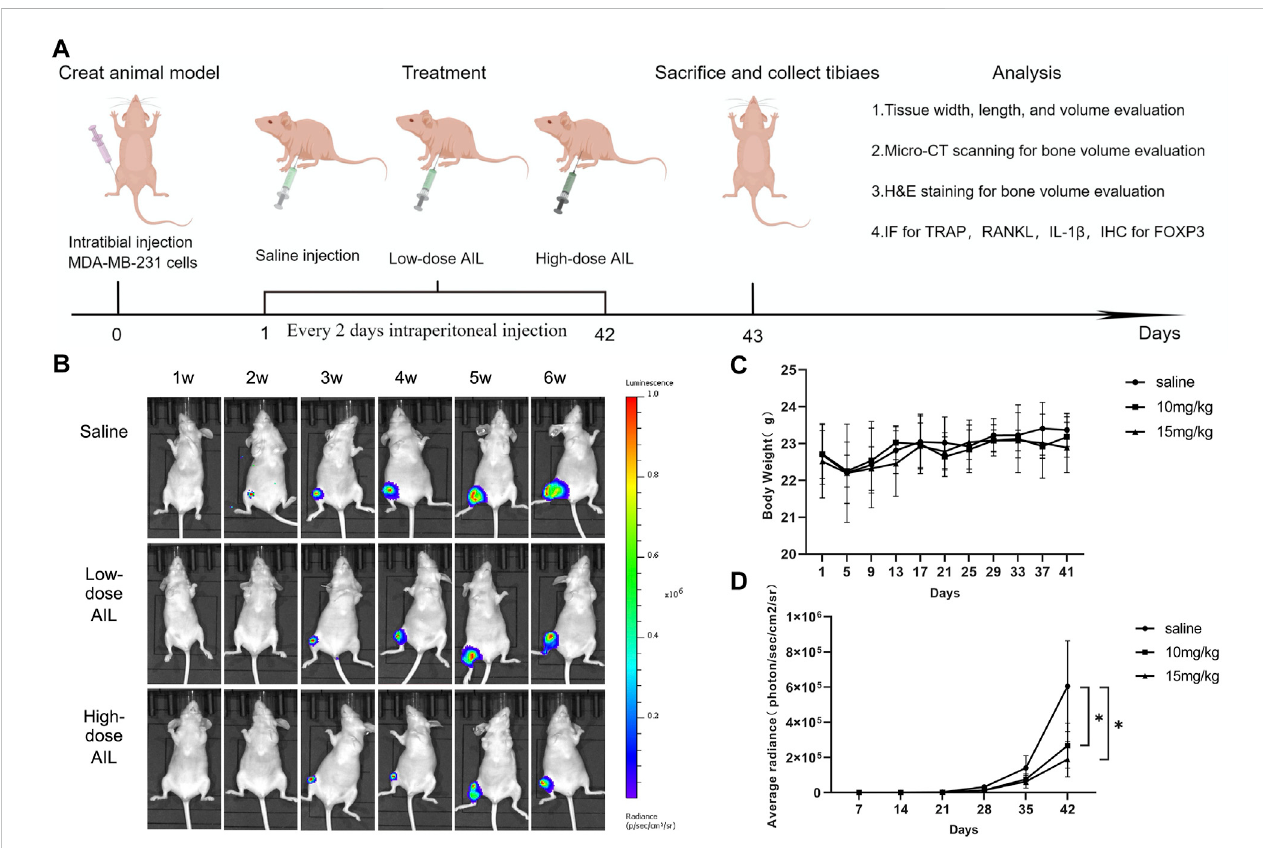
AIL prevents bone metastases and osteolysis brought on by BC and inhibits the evolution of the disease, in vivo . (A) The in vivo treatment timeline was created using the Figdraw software (ID: AIATW58585). A BC-induced bone metastasis model in mice was developed by injecting Luc cells into right tibial plateau of nude mice. (B) Non-invasive IVIS was used every week to identify the representative bioluminescence images for developing MDA-MB-231 Luc cells in the tibia of nude mice. (C) Every 4 days, the body weight variations in every group were assessed. (D) The graphs depicting the bioluminescence activity of tumor cells in the bone microenvironment with time. The mean ± SD were used to express all the data. * p < 0.05, ** p < 0.01, in comparison to the control